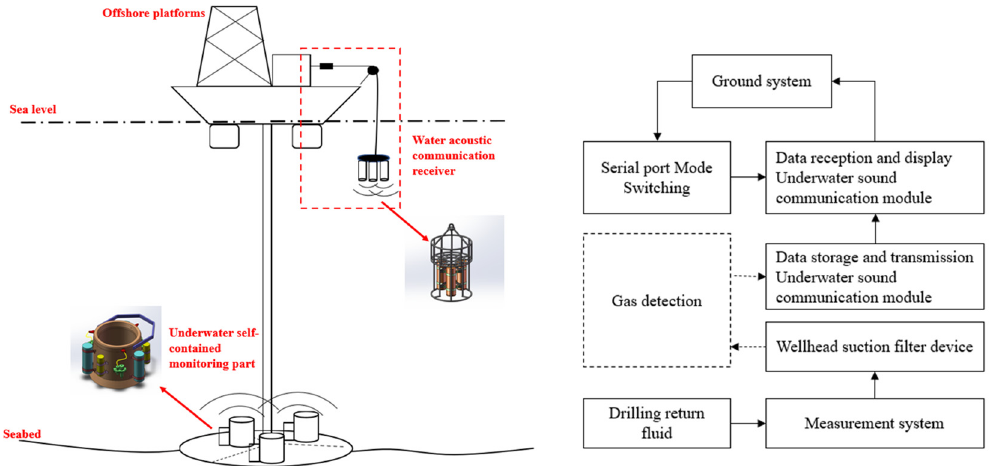
Figure 4. System working diagram and technical route.